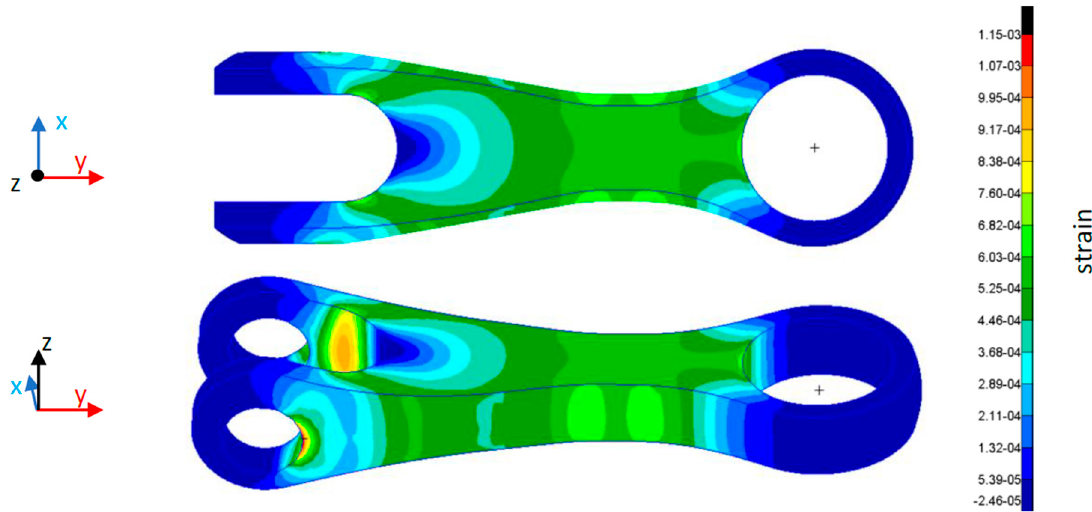
Figure 5. y -axis strain by finite element method (FEM) analysis of the composite item.